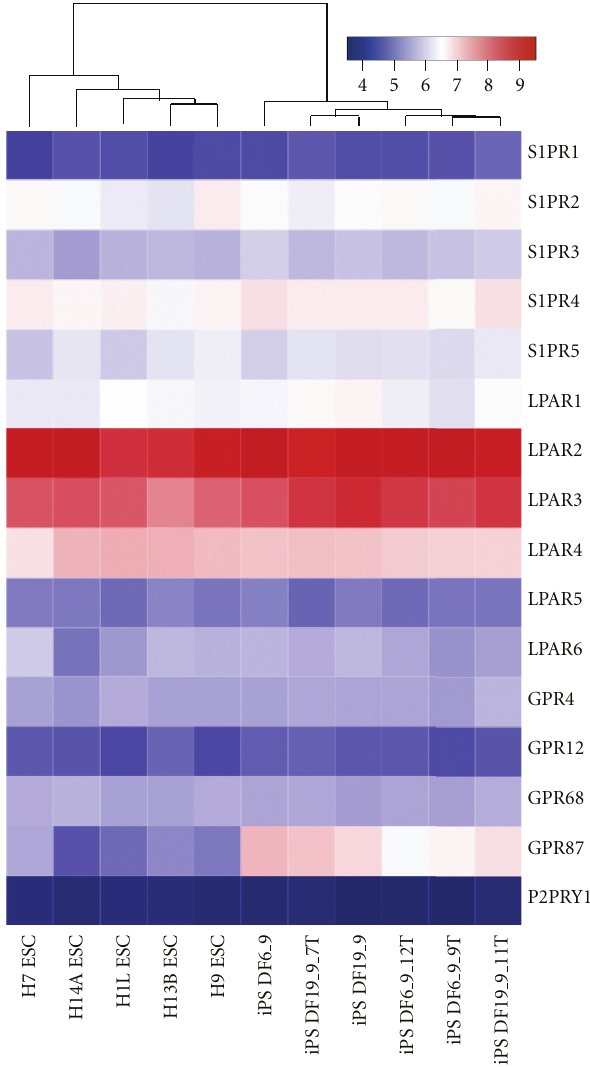
Figure 2: Lysophospholipid receptor expression in human pluripo- tent stem cells. Heatmap of microarray gene expression of a list of human bioactive lipid receptors. Gene expression color key is shown in log2 scale. Microarray data were downloaded from the GEO database; accession numbers